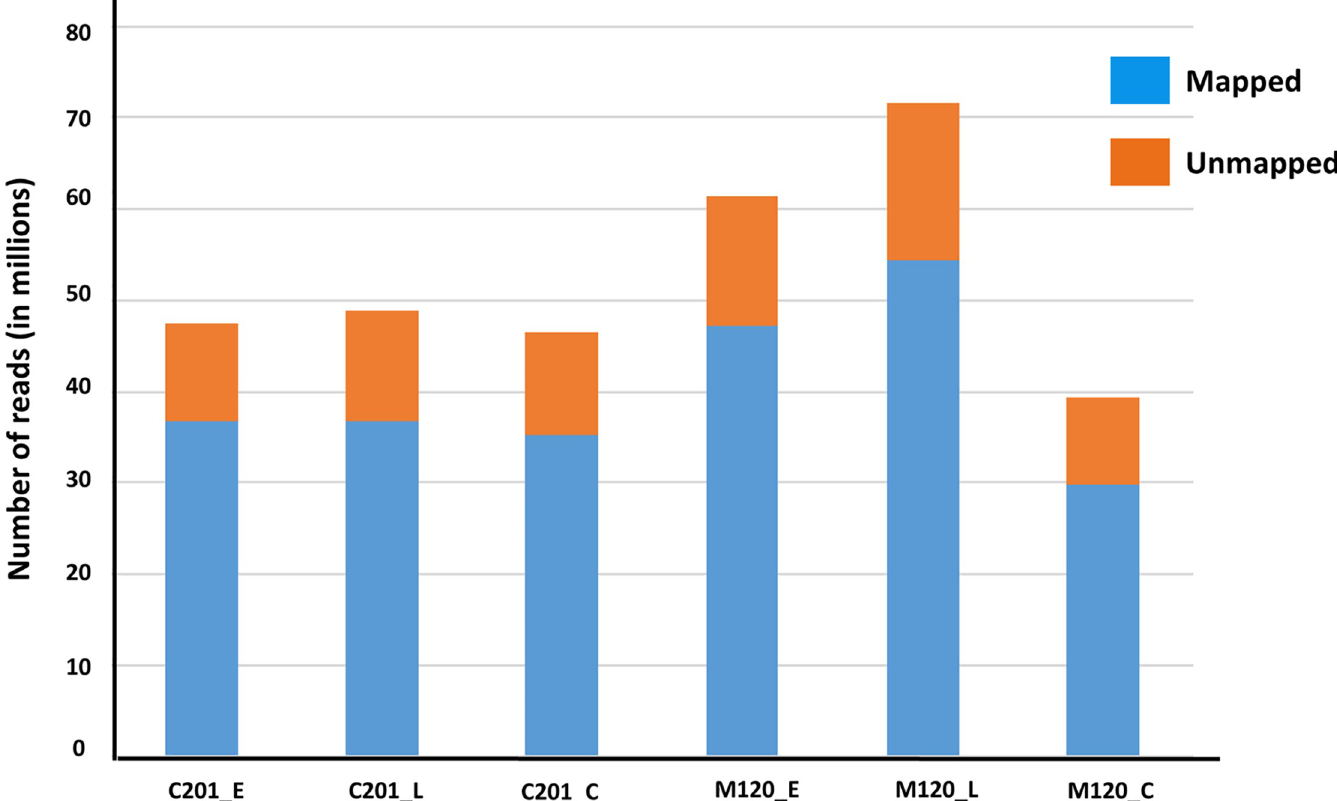
Fig 1. Average number of mapped and unmapped sequences at early (E), late (L) and control (C) sampling time point.